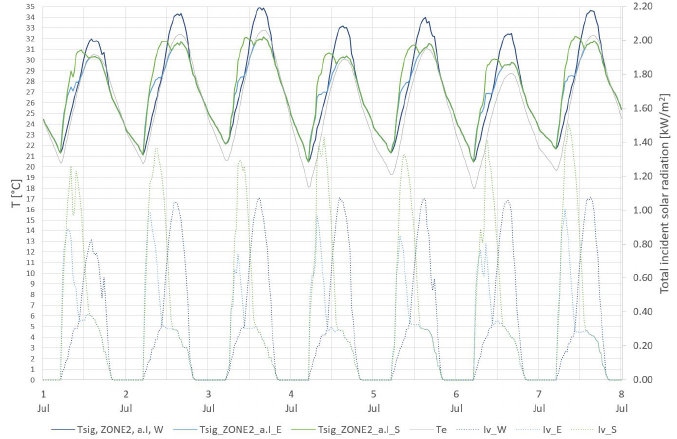
Figure 10. Internal surface temperature of current glazing system for different orientations; winter period: January, first week (floor 2).